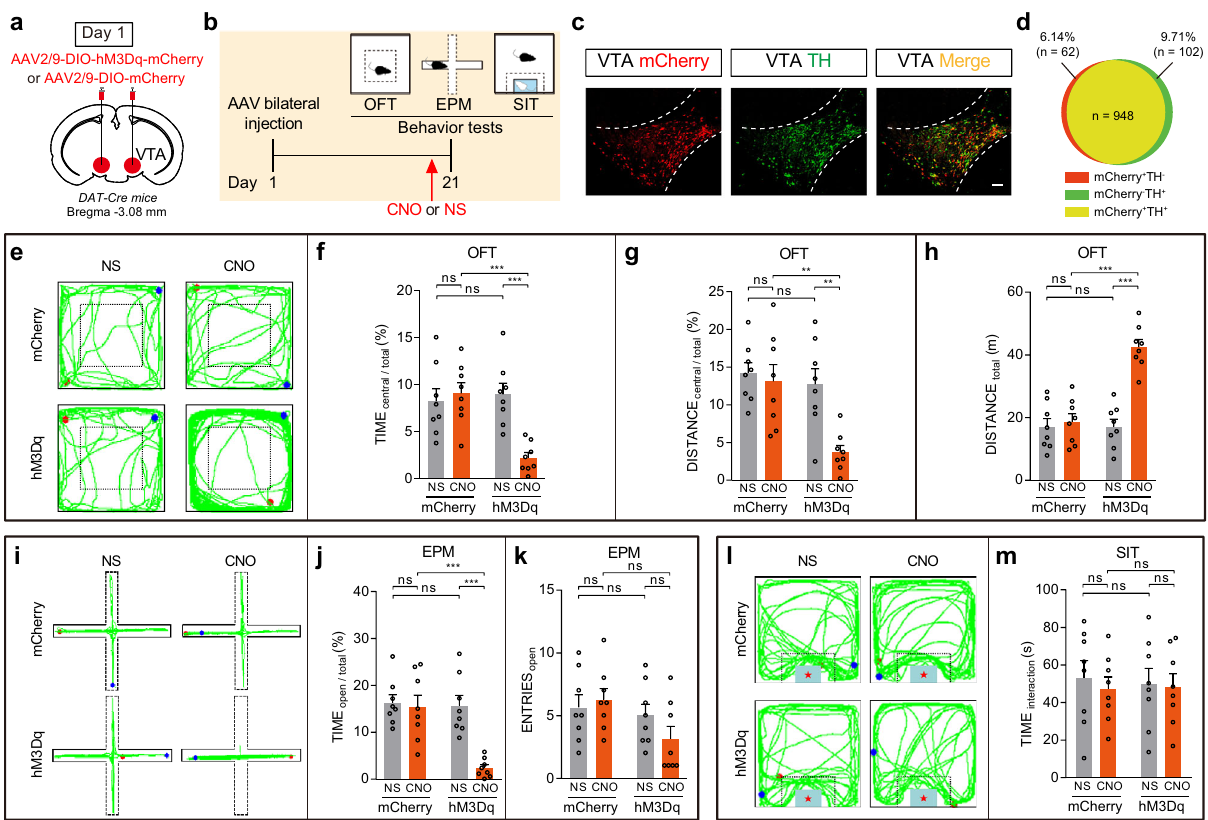
Fig. 3 Chemogenetic activation of VTA DA neurons in DAT-Cre mice directly triggers anxiety-like behavior. a Schematic of bilateral virus infection in DAT-Cre mice. b Experimental scheme of chemogenetic activation of VTA DA neurons and behavioral tests. c Representative image of VTA-injection sites. Scale bar, 100 μ m. d The quantitative analysis of Venn diagram shows the co-expression level of mCherry with TH in VTA (3 sections per mouse from 3 mice). e – h Results of OFT. e Representative exploration traces of OFT. f Percentage of time spent in the central area of OFT (two-way ANOVA, group: P = 0.0100, treatment: P = 0.0125, interaction: P = 0.0019; post hoc Tukey ’ s test, hM3Dq(NS vs. CNO): P = 0.0010, CNO(mCherry vs. hM3Dq): P = 0.0008). g Percentage of distance traveled in the central area of OFT (two-way ANOVA, group: P = 0.0038, treatment: P = 0.0068, interaction: P = 0.0303; post hoc Tukey ’ s test, hM3Dq(NS vs. CNO): P = 0.0052, CNO(mCherry vs. hM3Dq): P = 0.0034). h Total distance traveled in the OFT (two-way ANOVA, group: P = 4.97 × 10 − 5 , treatment: P = 9.13 × 10 − 6 , interaction: P = 5.60× 10 − 5 ; post hoc Tukey ’ s test, hM3Dq(NS vs. CNO): P = 4.78 × 10 − 7 , CNO(mCherry vs. hM3Dq): P = 1.49 × 10 − 6 ). i – k Results of EPM. i Representative exploration traces in EPM. j Percentage of time spent in the open arms of EPM (two-way ANOVA, group: P = 0.0014, treatment: P = 0.0009, interaction: P = 0.0032; post hoc Tukey ’ s test, hM3Dq(NS vs. CNO): P = 0.0002, CNO(mCherry vs. hM3Dq): P = 0.0003). k Number of open-arm entries in the EPM (two-way ANOVA, group: P = 0.0561, treatment: P = 0.5119, interaction: P = 0.1947; post hoc Tukey ’ s test, hM3Dq(NS vs. CNO): P = 0.5042, CNO(mCherry vs. hM3Dq): P = 0.1111). l , m Results of SIT. l Representative traces in SIT. m Statistics of time spent in the social interaction zone of SIT (two-way ANOVA, group: P = 0.8647, treatment: P = 0.6315, interaction: P = 0.7857; post hoc Tukey ’ s test, hM3Dq(NS vs. CNO): P = 0.9988, CNO(mCherry vs. hM3Dq): P = 0.9999). The red and blue dots in the OFT, EPM, and SIT locomotion traces re fl ect the start and end points of the mouse, respectively. n = 8 mice for each group. All data are shown